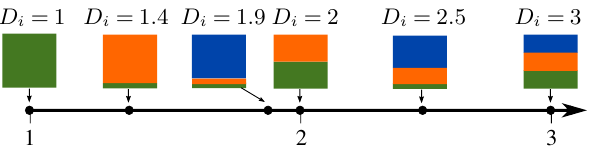
Fig. 1. Particle diversities D i of representative particles. The par- Fig. 3: Particle diversities D i of representative particles. The ticle diversity measures the effective number of species within a particle diversity measures the effective number of species particle, so a pure single-species particle has D i = 1 and a particle within a particle, so a pure single-species particle has D i = 1 consisting of 2 or 3 species in even proportion will have D i = 2 or and a particle consisting of 2 or 3 species in even proportion D i = 3, respectively. A particle with unequal amounts of 2 species will have D i = 2 or D i = 3 , respectively. A particle with un- will have an effective number of species somewhat less than 2, equal amounts of 2 species will have an effective number of while a particle with unequal amounts of 3 species will have effec- species somewhat less than 2, while a particle with unequal tive species below 3, and possibly even below 2 if the distribution is amounts of 3 species will have effective species below 3, and very possibly even below 2 if the distribution is very unequal.